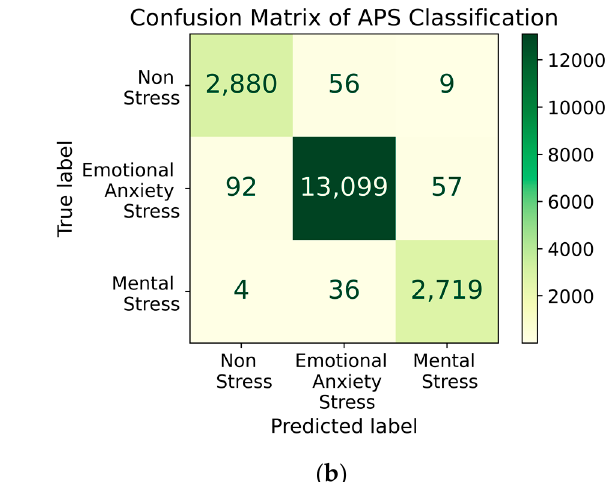
Figure 9. ( a ) Confusion matrix of PA types classification using the independent LSTM RNN (class imbalance mitigated by ADYSN); ( b ) Confusion matrix of APS types classification using the independent LSTM RNN. Synthetic samples from training split were regenerated by using ADYSN to avoid biased model training.